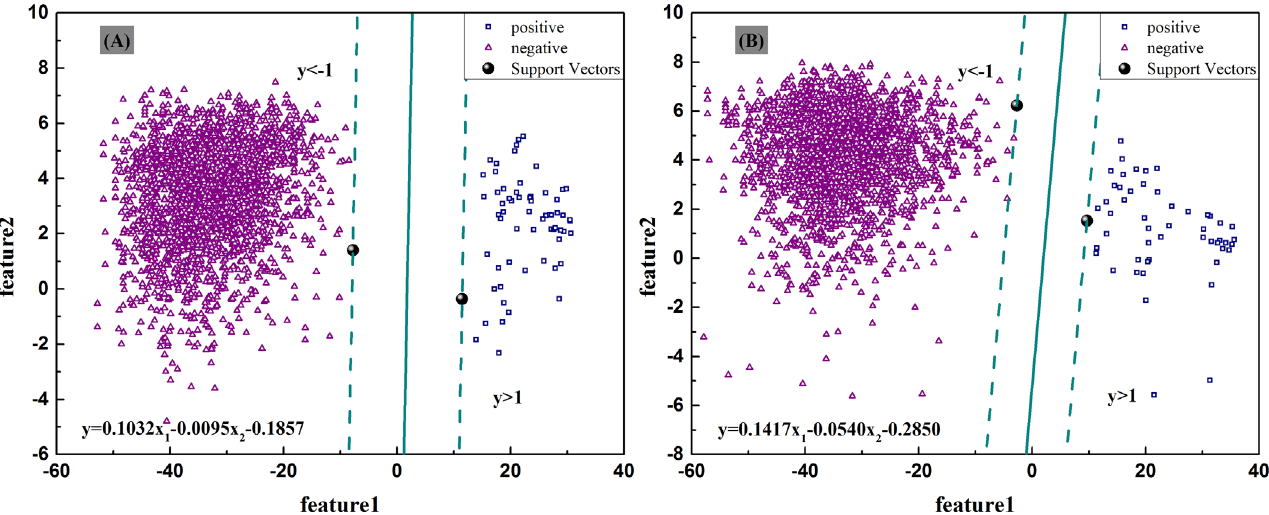
Fig 2. Classification results between positive and negative samples by SVM method. The solid lines represent the optimal classification hyperplanes constructed for (A) start samples and (B) end